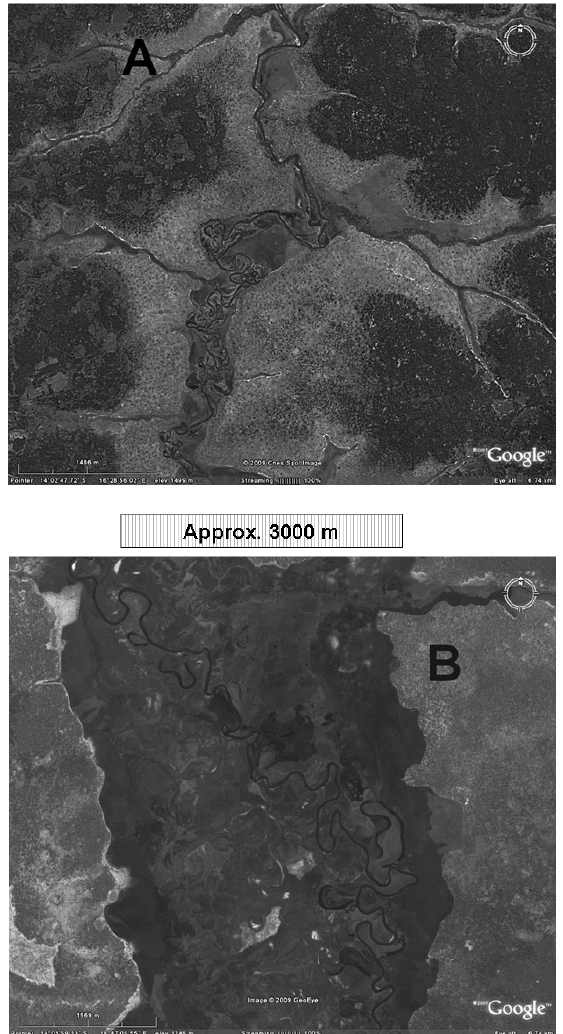
Fig. 3. Google Earth images of the Cubango (A) and Cuito (B) rivers at locations where their catchment areas are similar. Eye alti- tude is 6.74km in both